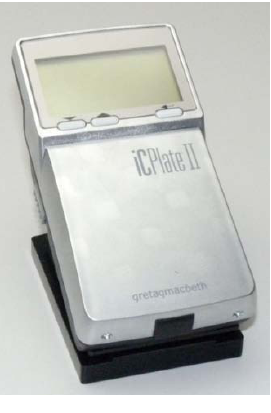
Figure 4. Gretag Macbeth’s IC Plate II (image taken from http://www.idd.tu-darmstadt.de/ media/fachgebiet_idd/forschungdienstleistung/ausstattung_3/icPlate.jpg). Courtesy of Xrite Company (http://www.xrite.com/).